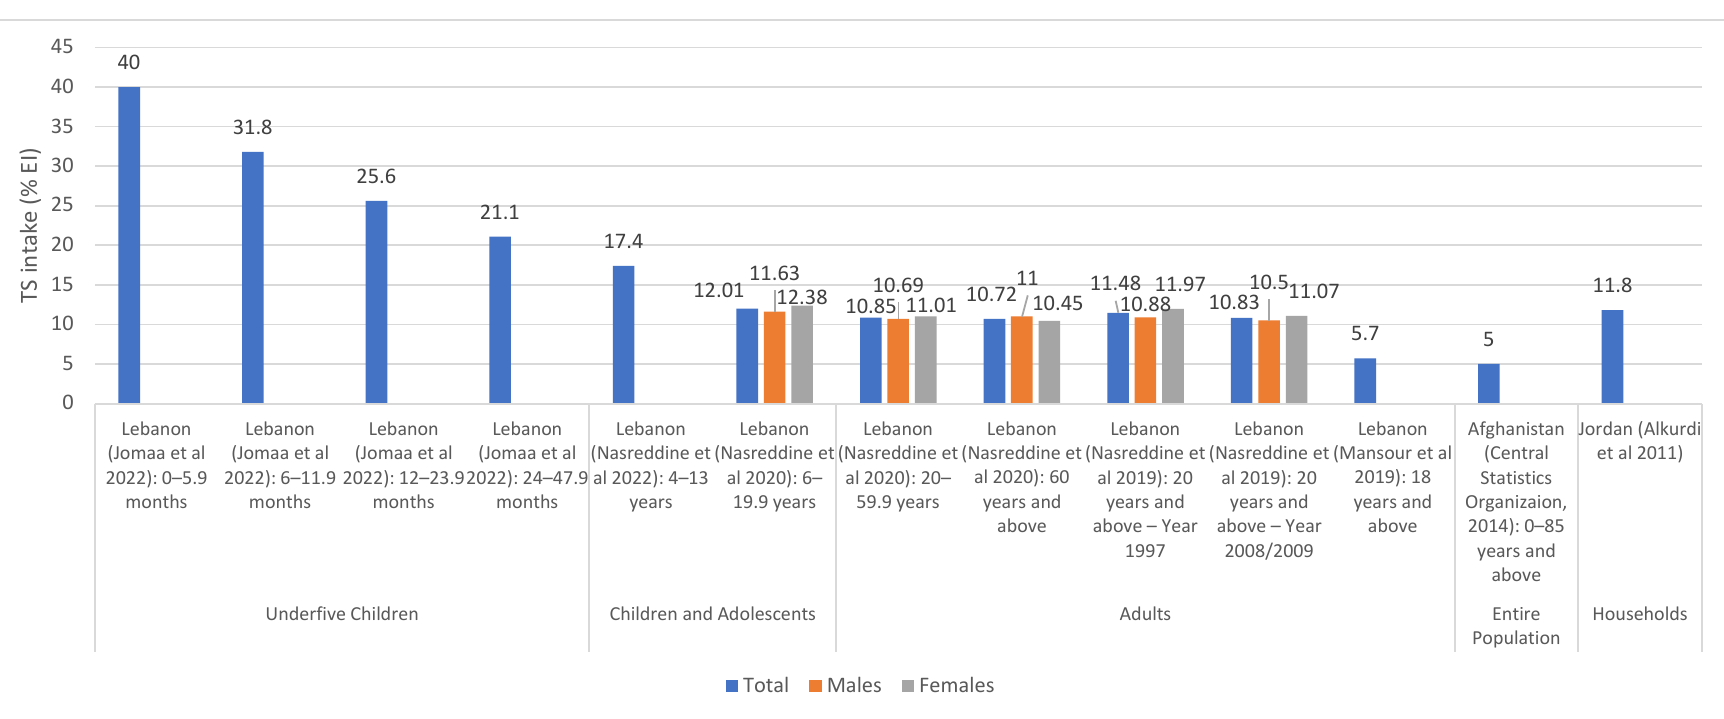
Figure 2. TS intake estimates (% EI) based on national studies in countries of the EMR. Abbreviations: EI: energy intake; EMR: Eastern Mediterranean Region; TS: